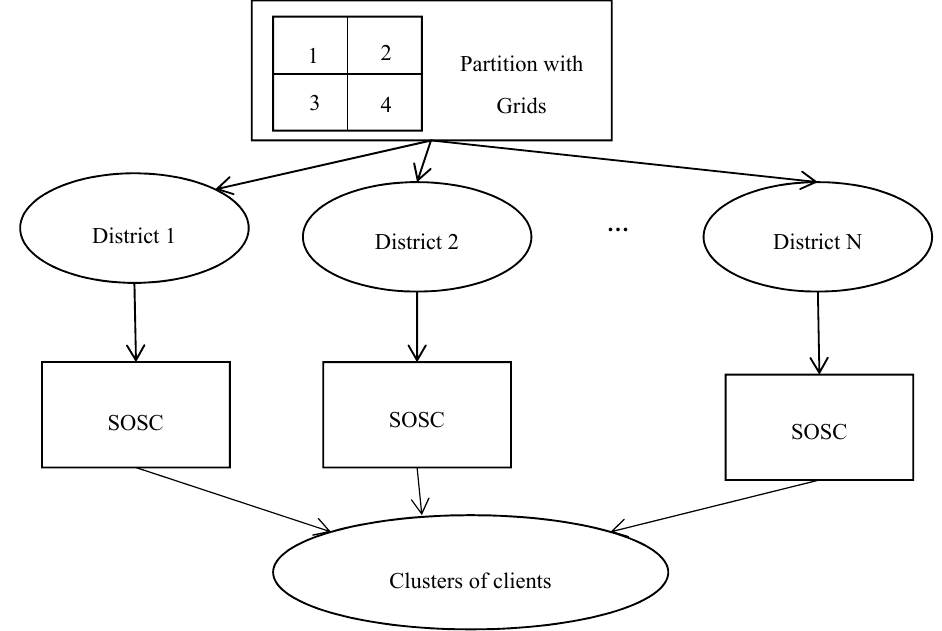
Figure 5. The scheme of parallel computing for ultra-large scale network RTK systems. SOSC: self-organizing spatial clustering.